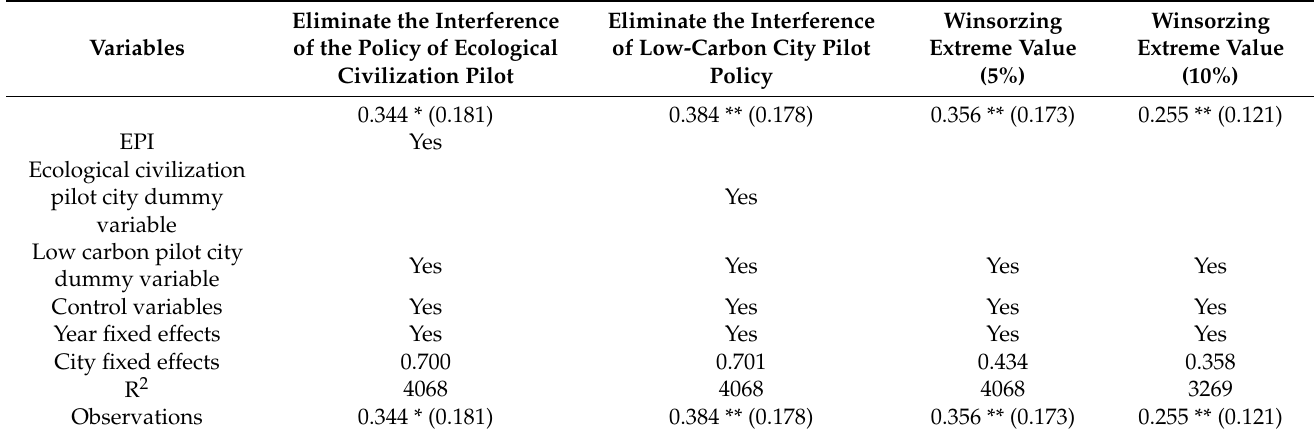
Table 4. Eliminate the interference of other policies and winsorzing extreme value.